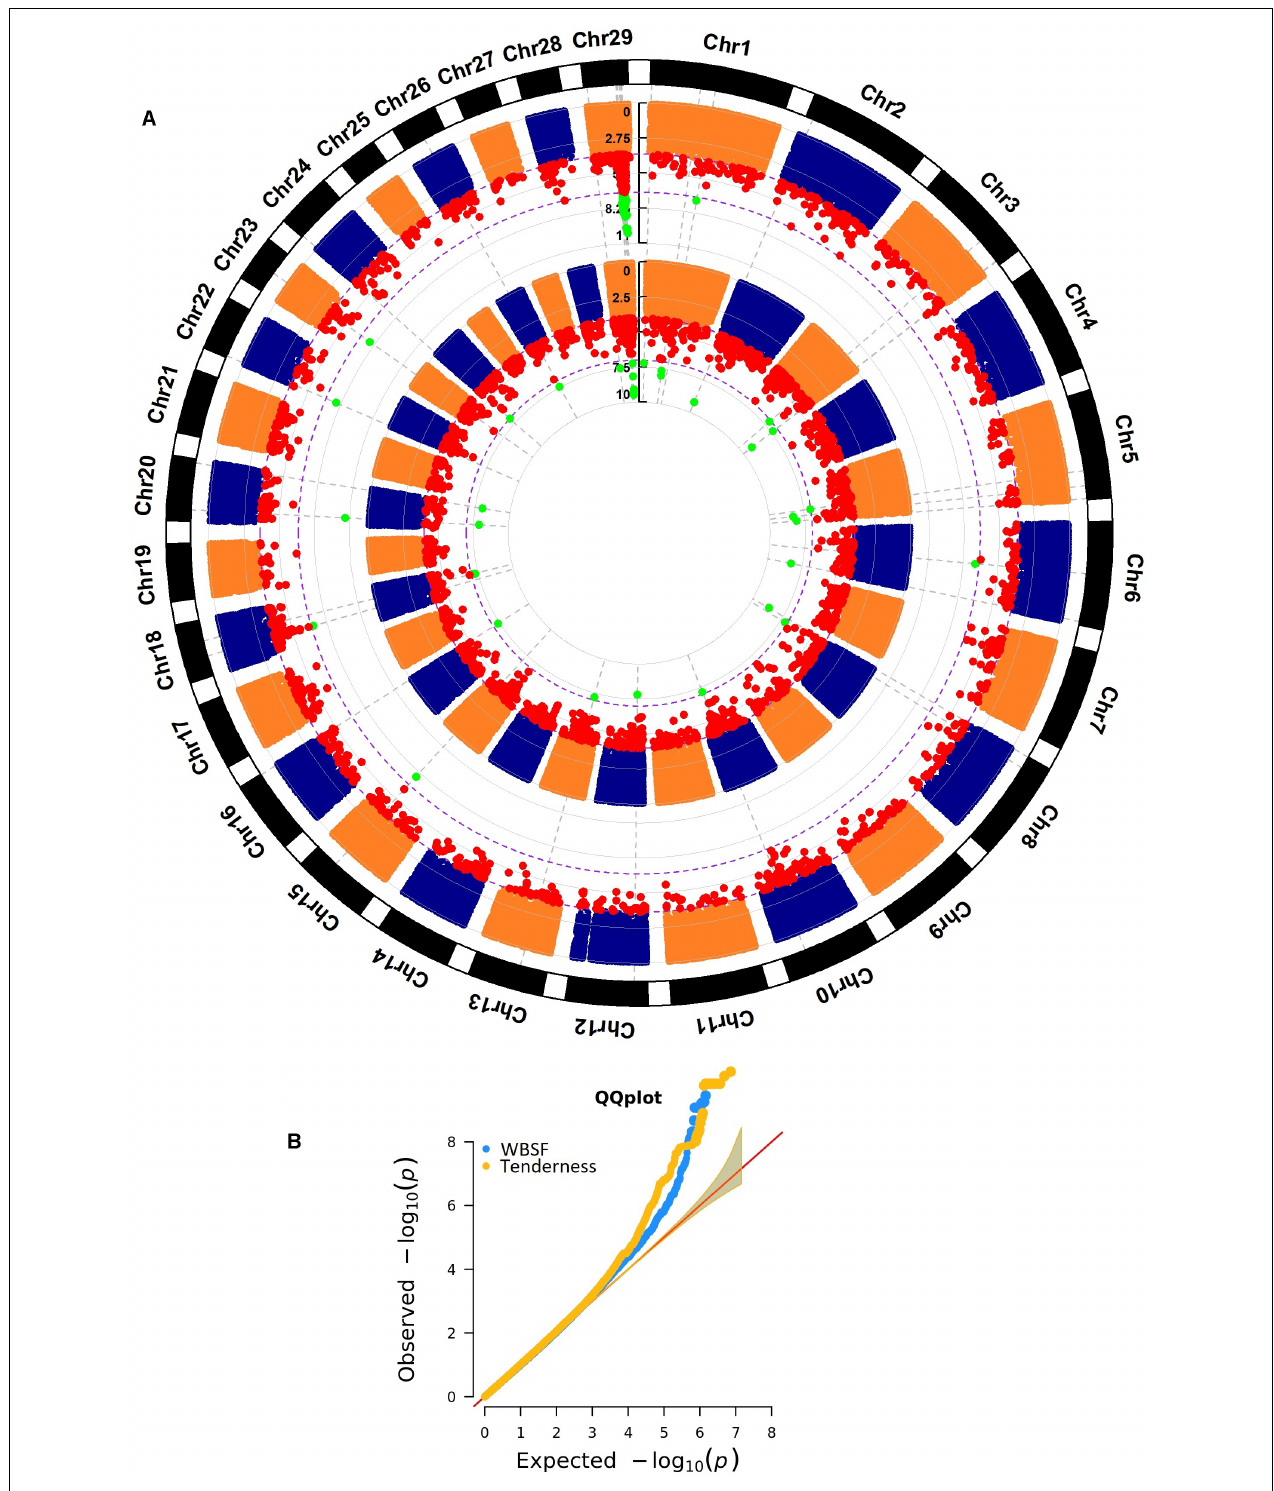
FIGURE 1 | (A) Whole genome association results for WBSF (internal Manhattan plot) and tenderness (external Manhattan plot) in longissimus dorsi muscle in an Angus population. The significance thresholds are 1 × 10 - 4 and 1 × 10 - 7 , respectively. (B) Q–Q plot for the whole genome association analyses for WBSF and tenderness. Five highly significant markers for WBSF were excluded from this graph ( p -value ≤ 1.1 × 10 - 17 ) but they are presented in Supplementary Table S1 .